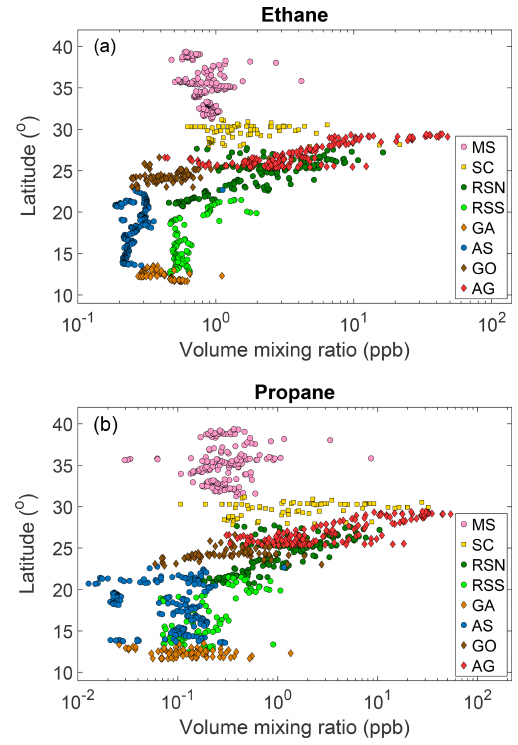
Figure 4. Latitudinal distribution of ethane (a) and propane (b) vol- ume mixing